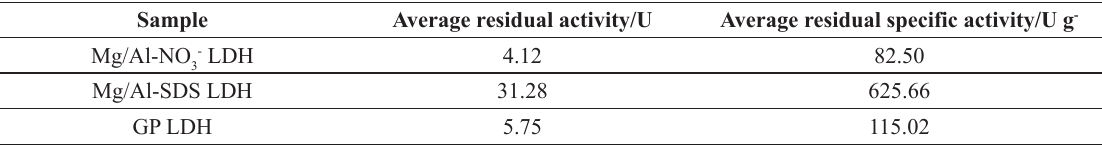
Table 2: Average residual and specific activities of immobilized enzyme samples of 0.0500 g of dry